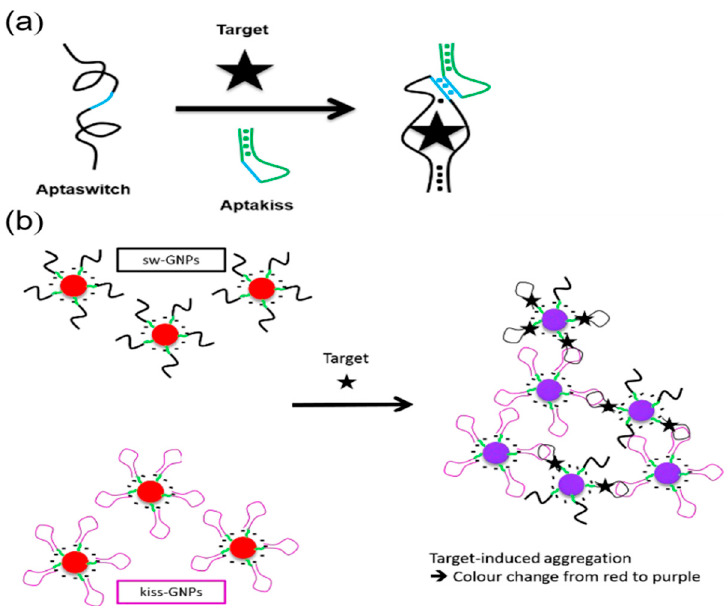
Figure 3. ( a ) The schematic illustration of the formation of an aptamer kissing complex. The loop-loop interaction is shown in blue. ( b ) The principle of the cross-linking aggregation of AuNPs induced by the aptamer kissing complex. Reproduced with permission from Reference [47]. Royal Society of Chemistry, 2017.